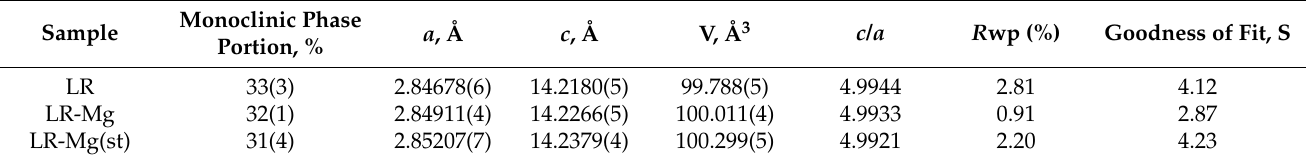
Table 1. Refinement unit cell parameters of LR, LR-Mg, and LR-Mg(st) oxides (space group R 3 m ).